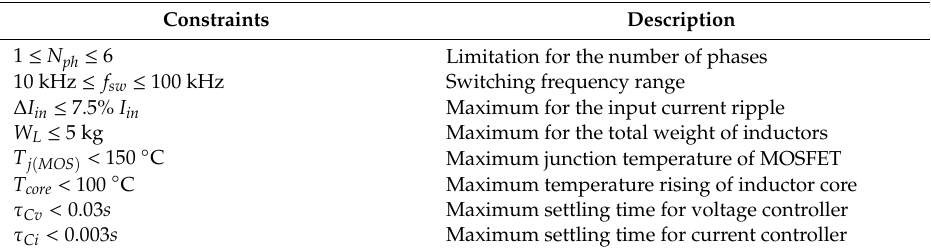
Table 3. Constraint description.